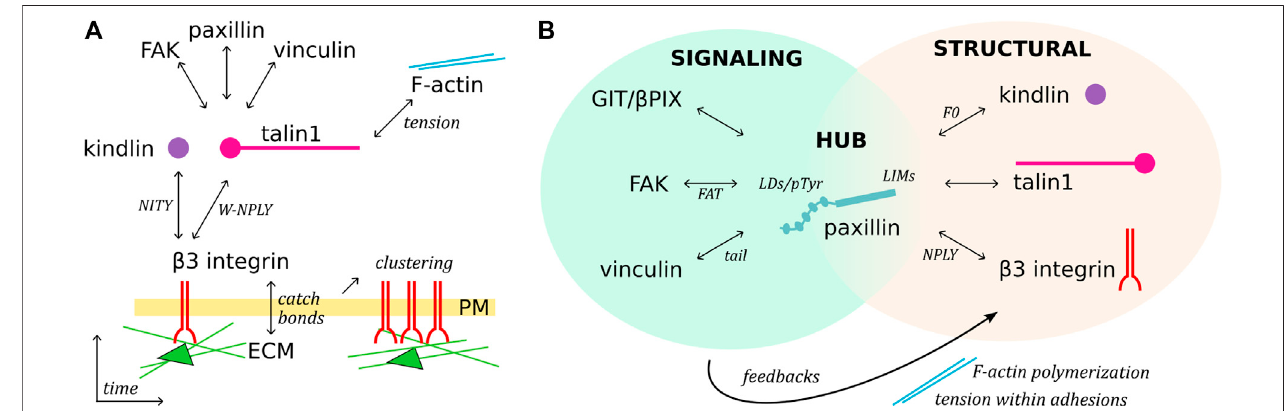
FIGURE2| Temporalsequence of β 3 integrin activation and paxillin-mediatedorganizationofadhesions. (A) , Schematic representation ofFAassembly over time. Ligand, talin and kindlin binding to integrin receptors triggers their clustering, mediates the mechanical connection with the F-actin network, and recruits cytoplasmic proteins. (B) , Paxillin is a structural, signaling and linker component of FAs. C-terminal LIM domains target paxillin to FAs, possibly directly interacting with talin, kindlin, and β 3 integrin (putative domains indicated). The paxillin N-terminus functions as a signaling molecule, binding/recruiting different subsets of FA proteins, modulating F-actin polymerization and tension within adhesions, and therefore generating feedback signaling which can lead to FA